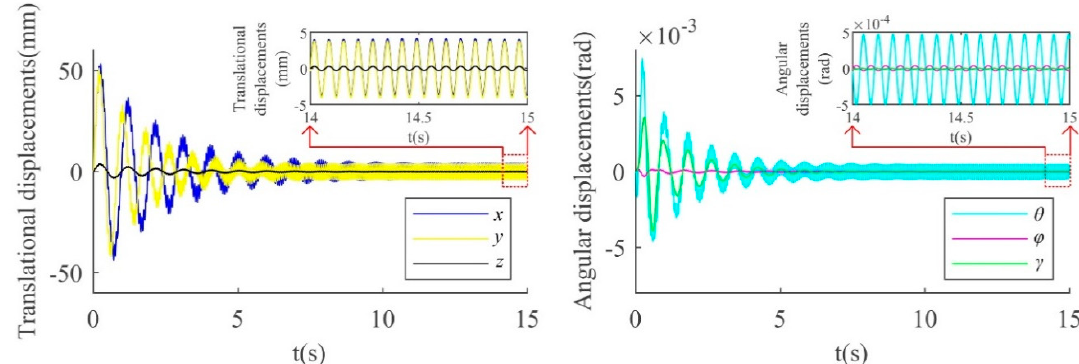
Figure 6. Displacement curves of the rigid body mass center under spring failure conditions, including three translational displacements ( x , y , z ) and three angular displacements ( γ , φ , θ ).